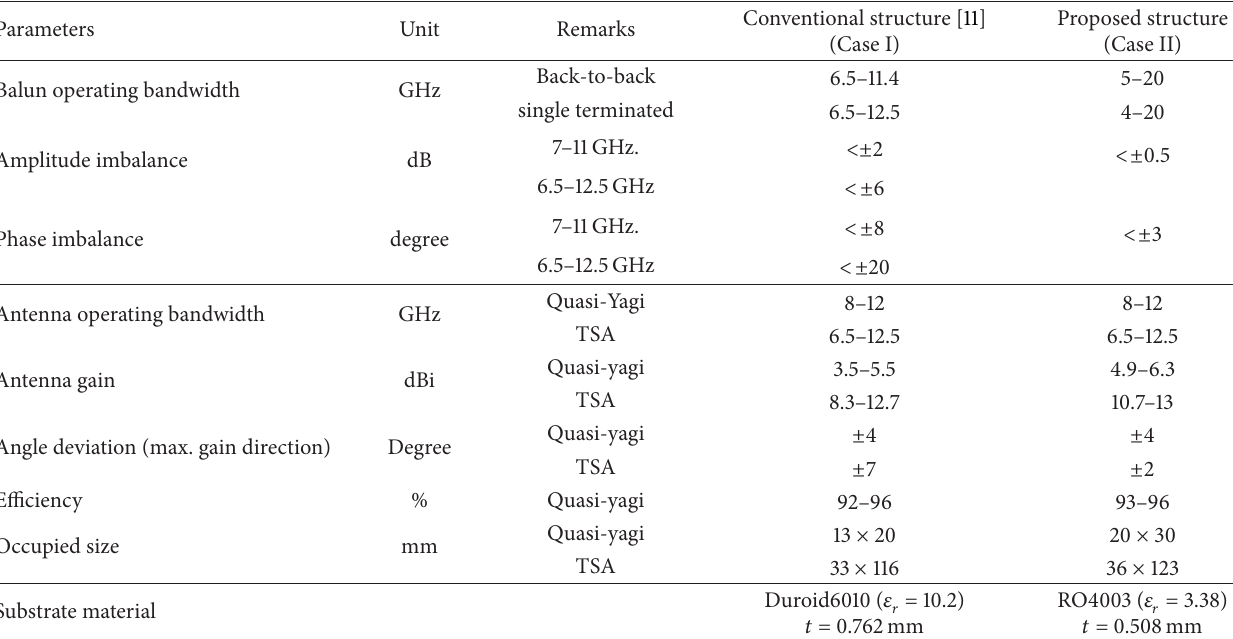
Table 1: Performance summary of the balance